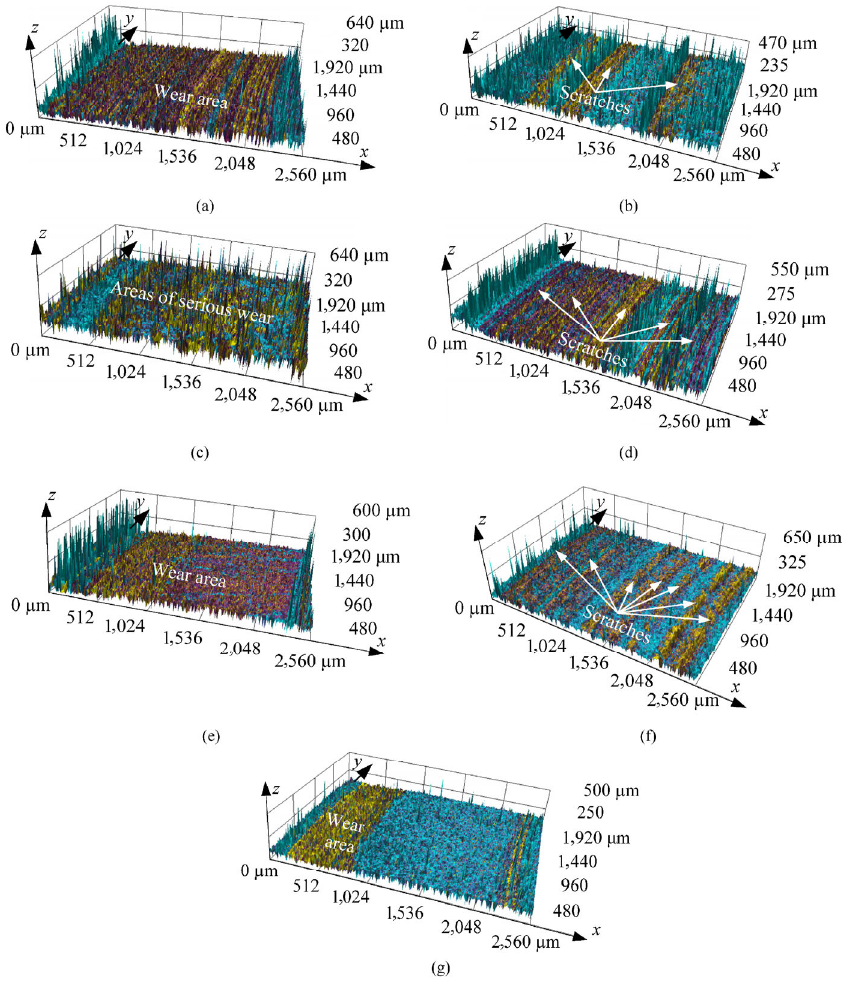
Fig. 6 3-D profiles of wear scars on the (a) PTFE, (b) PEEK, (c) GFER, (d) ABS resin, (e) CFRPAI, (f) POM, and (g) CFRPEEK surfaces after friction experiment lubricated by